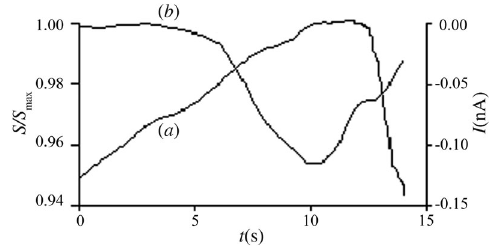
Fig. 10. PSC peak at diagonal fracture of a marble sample (MD018). Curve ( a ) corresponds to stress changes on a normalized axis; curve ( b ) corresponds to